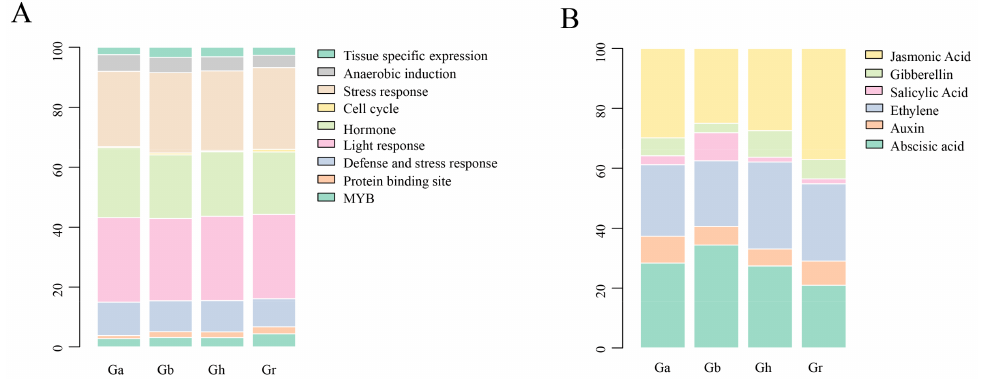
Figure 7. Distribution of cis-elements of GPDH members in G. hirsutum . The block size represents the proportion, and different rectangles are filled with different colors. ( A ) Inducible cis-elements. ( B ) Hormone-related cis-elements.